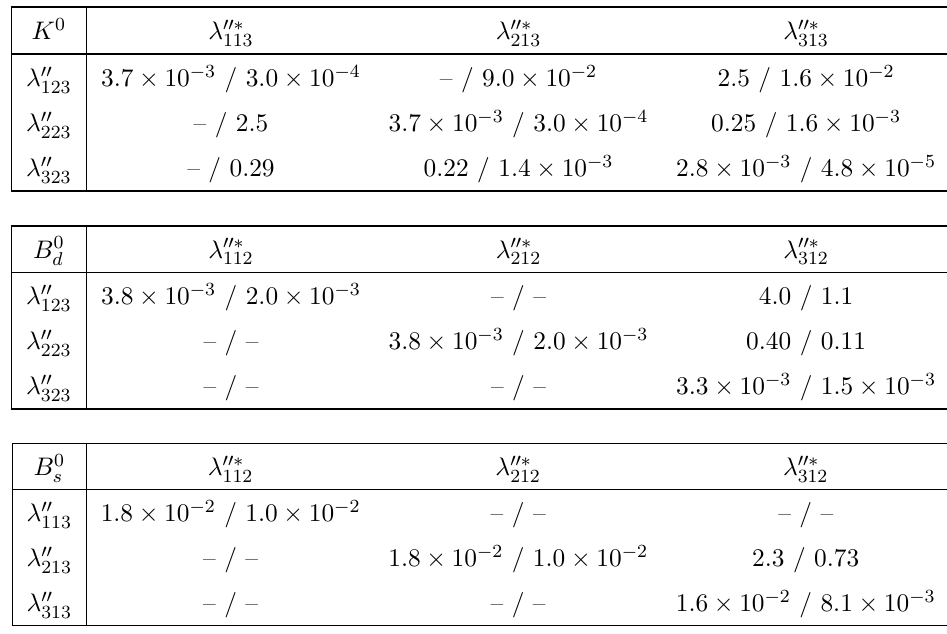
Table 4. Constraints on products of RPV couplings from neutral meson oscillations. Each of the K 0 , B 0 and B 0 systems constrain di(cid:11)erent combinations of couplings. For each product, the (cid:12)rst s d limit assumes that the NP contribution is aligned with the SM one, while the second one assumes maximal CP-violating phase. A line indicates that the derived limit is above the unitarity bound on the couplings. The limits are computed assuming a universal squark mass m ~ q = 1 TeV, and scale with m ~ q (diagonal ones) or m 2 (o(cid:11)-diagonal ~ q